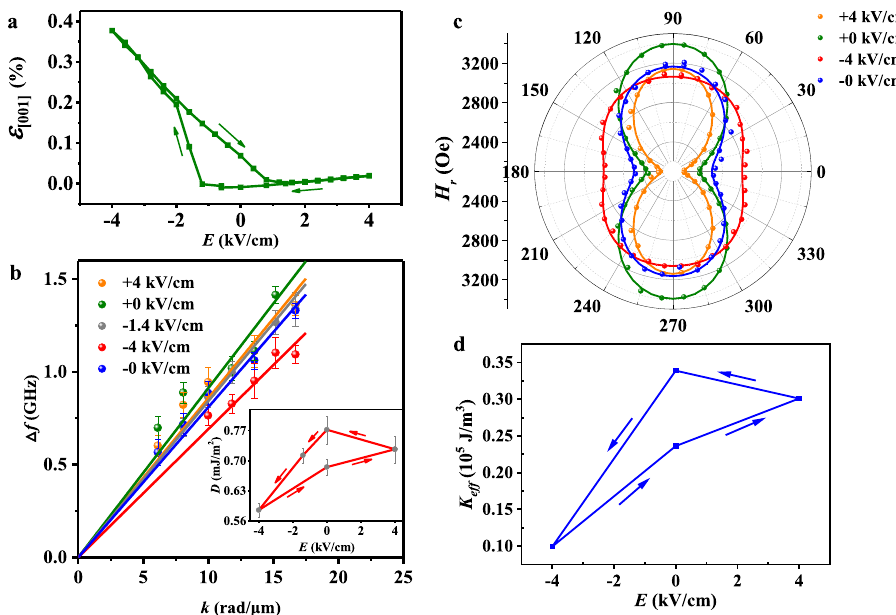
Fig. 2 Variations of strain, interfacial DMI, and magnetic anisotropy. a Out-of-plane strain variations of PMN-PT(001) substrate. b Wave-vector dependence of Δ f under different electric fi elds with the interfacial DMI values in the inset with the error bar obtained from the standard error of Lorentzian fi tting. c Angle-dependent FMR resonance fi eld H θ ) and corresponding Kittel formula fi tting (solid lines). d K fi eld r ( eff versus electric-